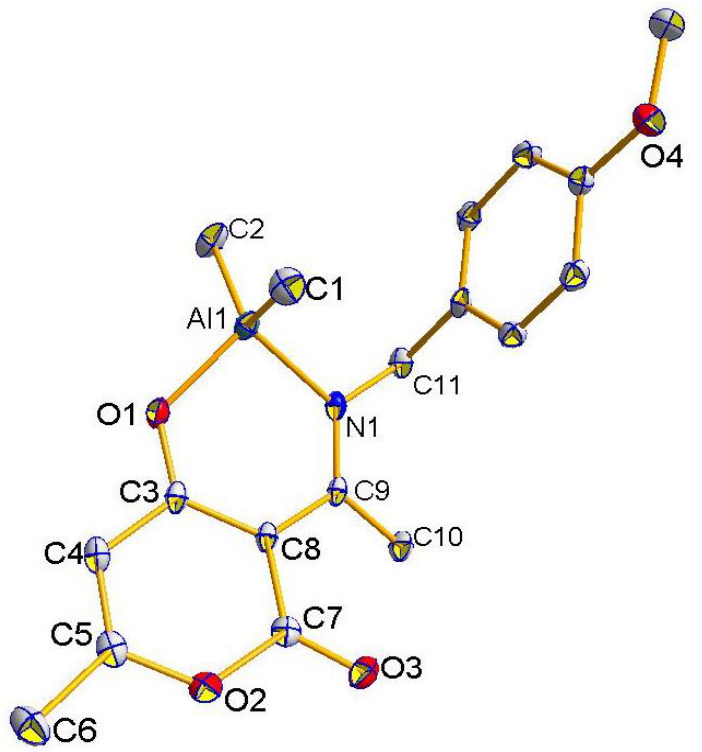
Figure 3. The molecular geometry of compound 3 . Thermal ellipsoids are drawn at the 30% probability level. THF and all the hydrogen atoms are omitted for clarity.